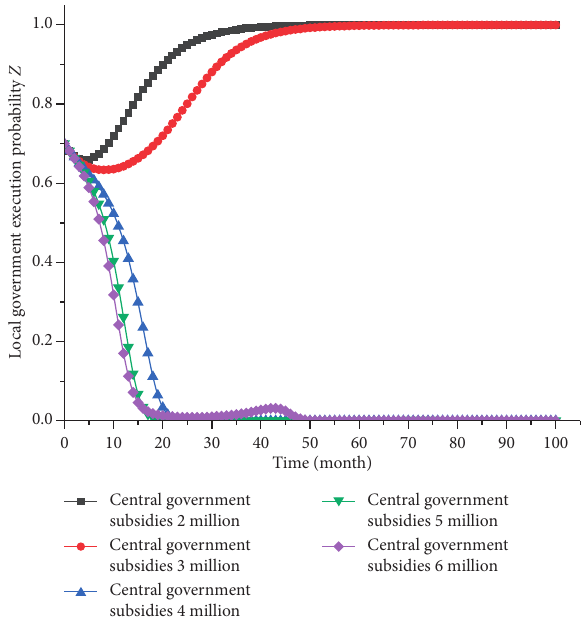
Figure 16: The impact of local fines on the strategic choice of mining